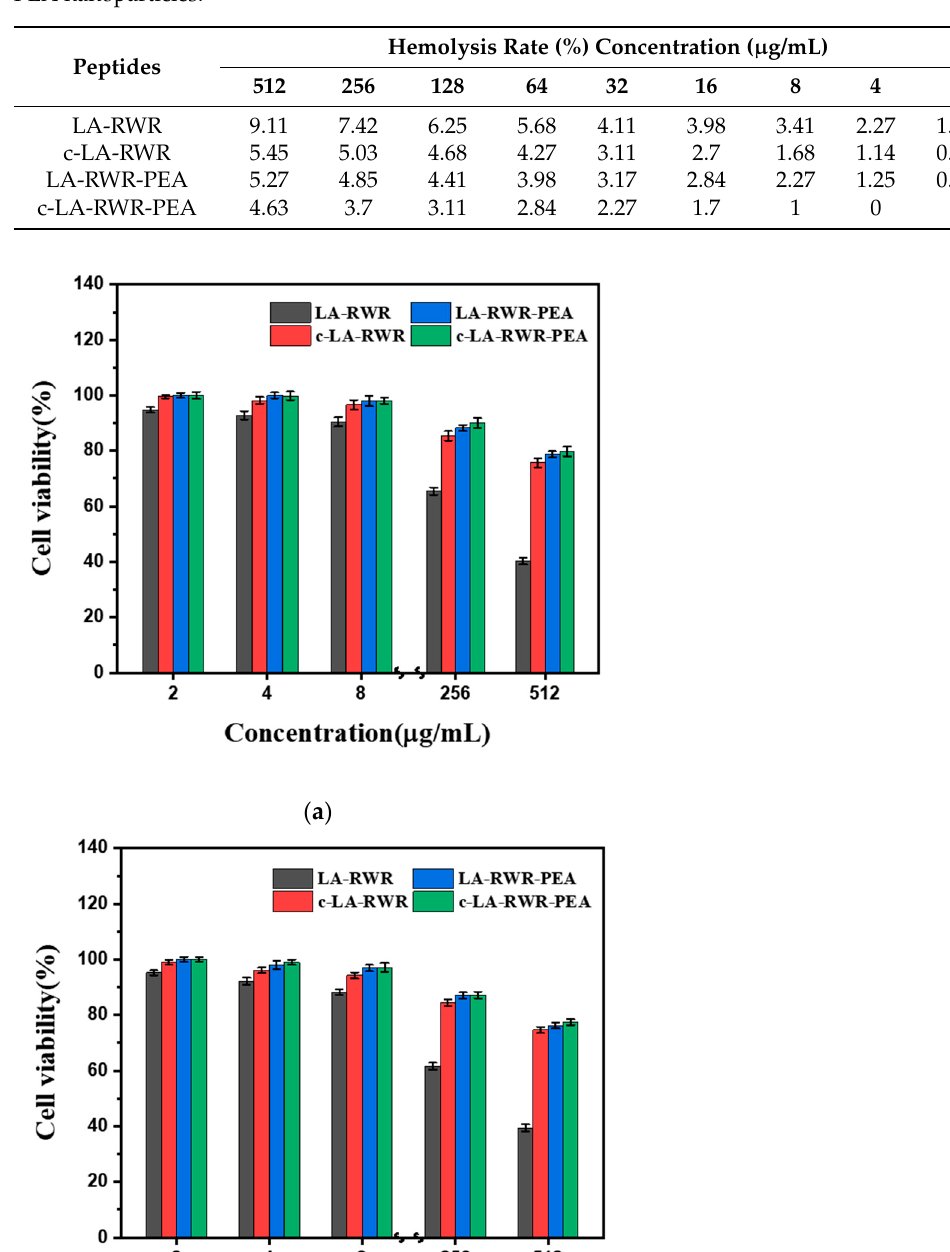
Table 3. Hemolysis rates of LA ‐ RWR, c ‐ LA ‐ RWR nanoparticles, LA ‐ RWR ‐ PEA, and c ‐ LA ‐ RWR ‐ PEA nanoparticles.